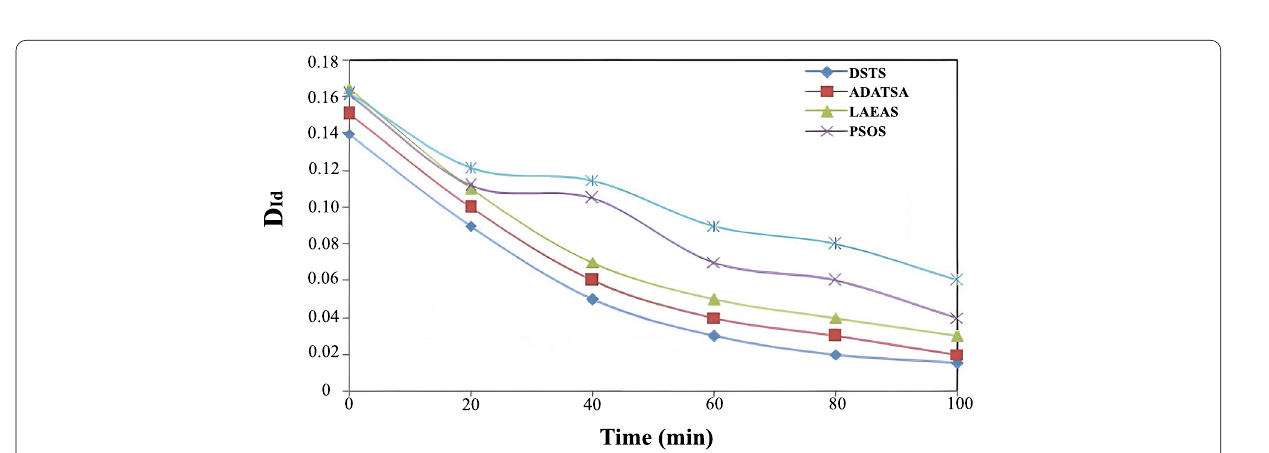
Fig. 10 Comparative analysis of resource imbalance degree (D Id ) with time